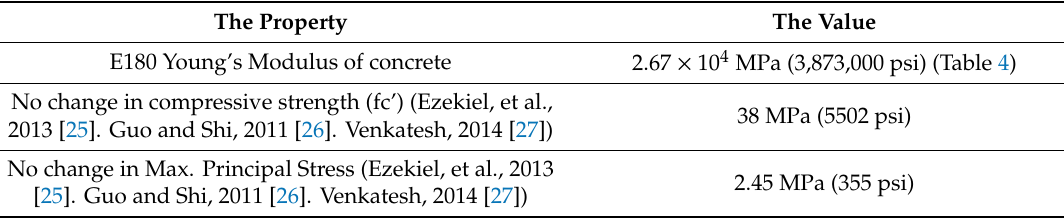
Table 7. Concrete Properties at 180 ◦ C.